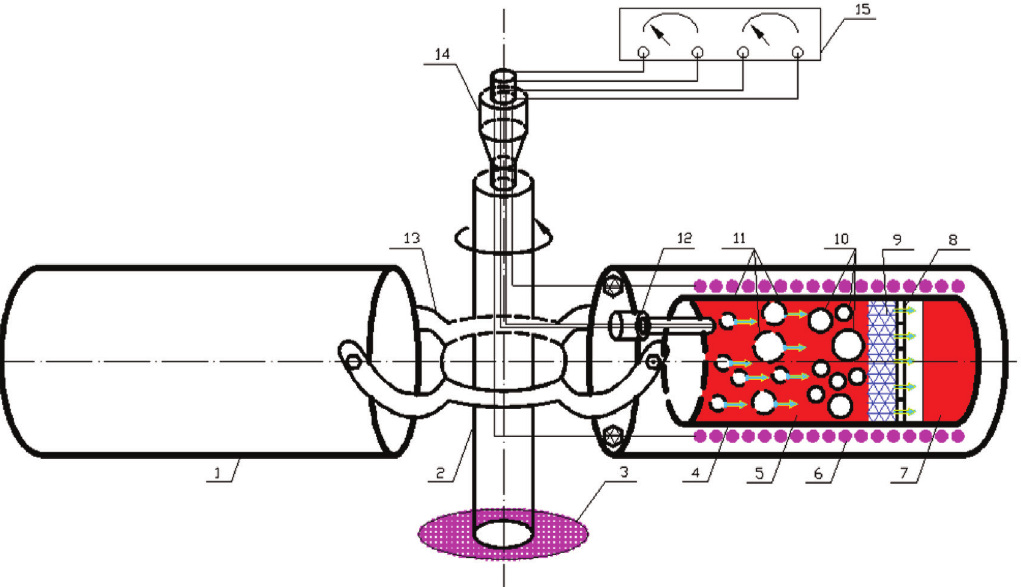
Fig. 3: Schematic diagram of centrifugal separation apparatus (1. Counterweight; 2. Centrifugal axis; 3. Base; 4. Graphite crucible; 5. Gangue melt before centrifugal separation; 6. Resistance coil; 7. Gangue melt after centrifugal separation; 8. Filter plate; 9. Carbon fiber; 10. Britholite crystals after centrifugal separation; 11. Britholite crystals before centrifugal separation; 12. Thermocouple; 13. Horizontal rotor; 14. Conductive slipping; 15. Temperature